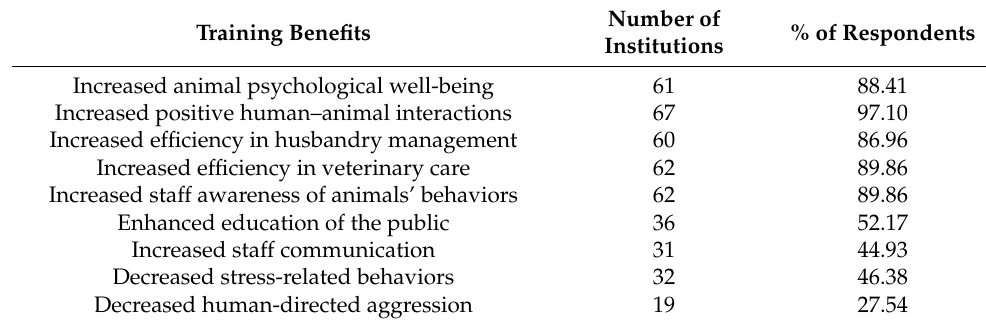
Table 5. Benefits reported of training strepsirrhine species in North American institutions ( n = 69). Training Benefits